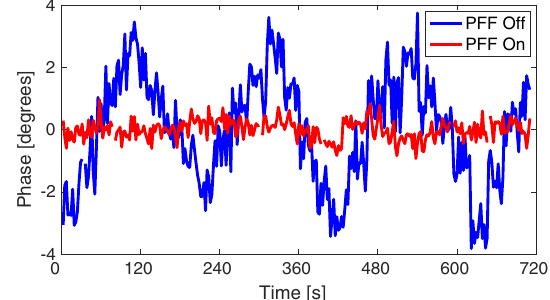
FIG. 8. Mean downstream phase vs time with the PFF system off (blue) and on (red) subject to large additional phase variations added to the incoming phase (see